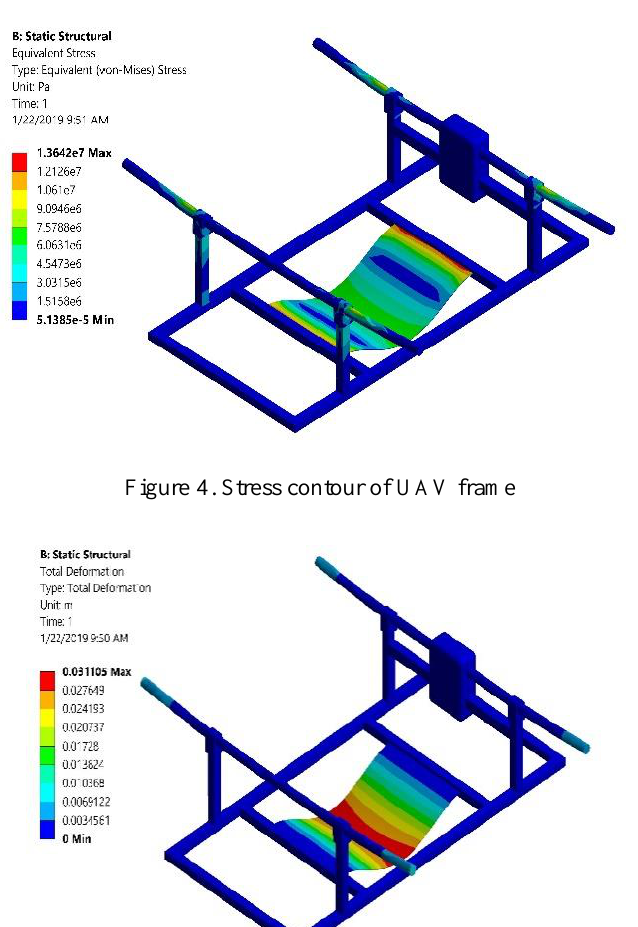
Figure 3. Frame with boundary condition